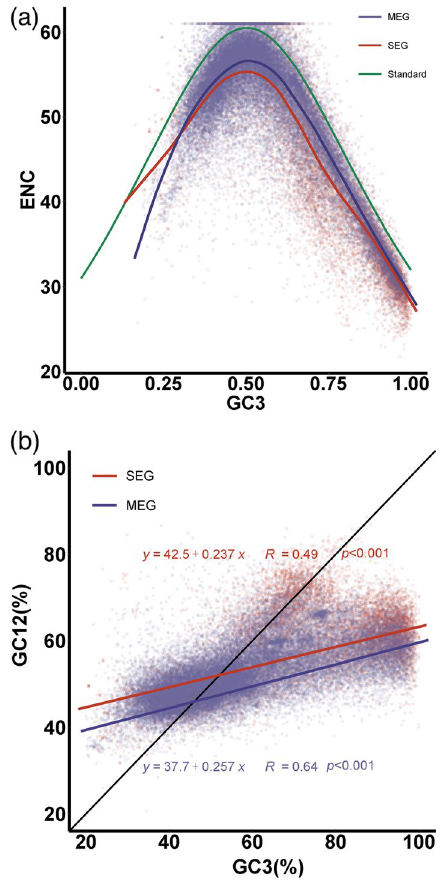
Fig. 4 ENC plot (ENC vs. GC3) and neutrality plot (GC12 vs. GC3) analyses of single-exon genes and multiple-exon genes in rice. a ENC plot analysis. The theoretical curve (green) represents the expected relationship between ENC and GC3 values. The simulated polynomial regression lines are shown in red and blue for the SEGs and MEGs (under the theoretical line), respectively. b Neutrality plot analysis. The theoretical line (black) represents the expected relationship between GC12 and GC3 values. The simulated regression lines are shown in red and blue for the SEGs and MEGs,